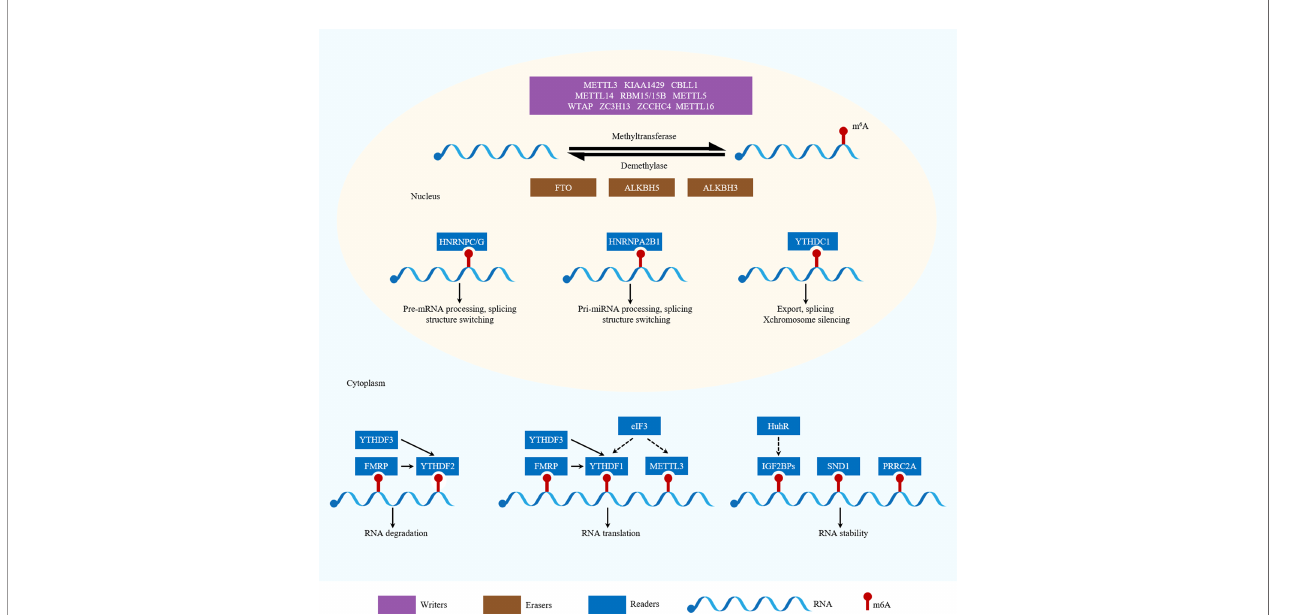
FIGURE 1 | Functions of m6A-related regulators in RNA metabolism. m6A is catalyzed by writers and removed by erasers. METTL3, METTL14, WTAP, KIAA1429, RBM15/15B, ZC3H13, CBLL1, METTL5, ZCCHC4 and METTL16 are writers. ALKBH5, ALKBH3 and FTO are erasers. YTHDF1, YTHDF2, YTHDF3, YTHDC1, YTHDC2, hnRNPC/G, hnRNPA2B1, FMRP, eIF3, IGF2BPs, SND1 and PRRC2A are readers. Different readers binding to m6A sites can produce different biological